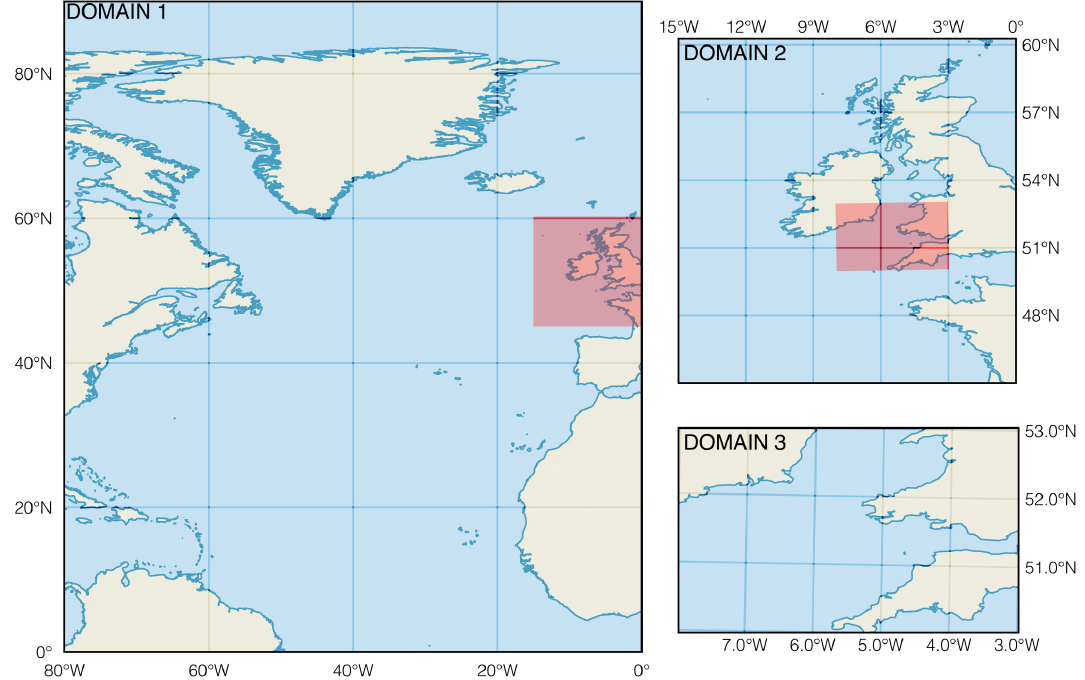
Figure 4. The three nested domains of the WAVEWATCH III model. Shaded areas highlight location of the nested domain.